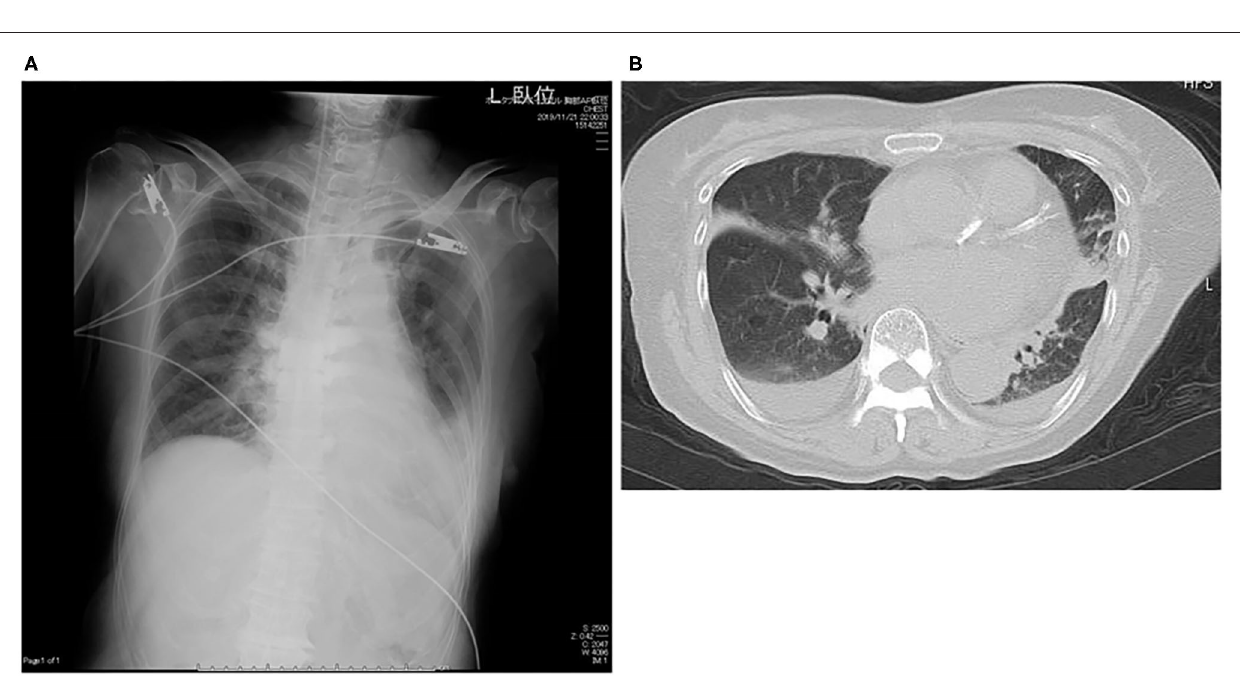
ranges from 6.6% (TJ-54) to 33% (TJ-9 and TJ-68) according to the Japanese Adverse Drug Report Database